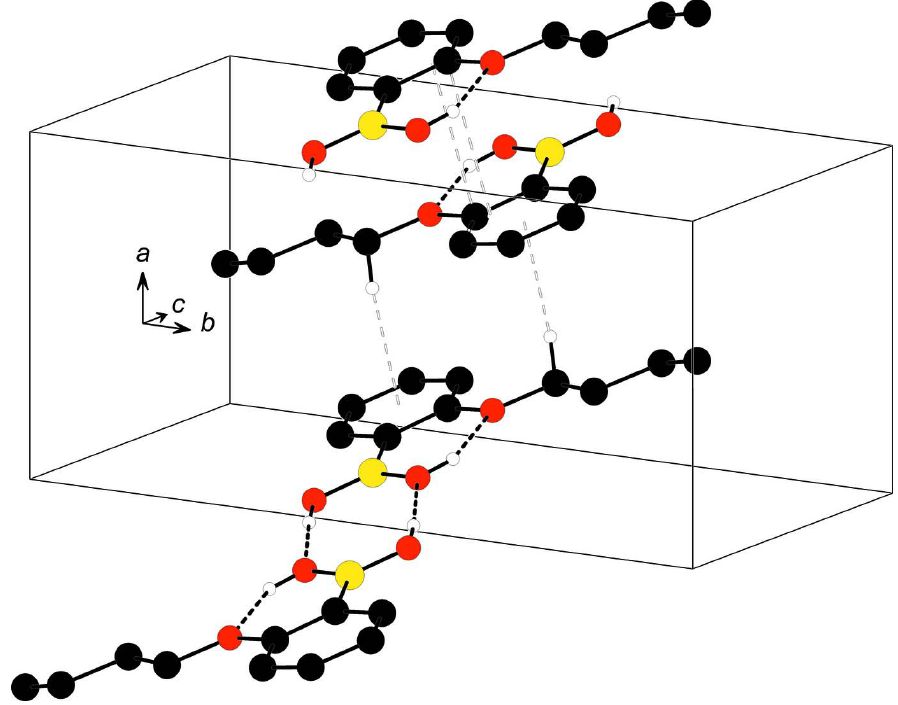
Figure 2 The crystal packing in (I) showing hydrogen-bonding, C—H– π and π – π interactions as dashed